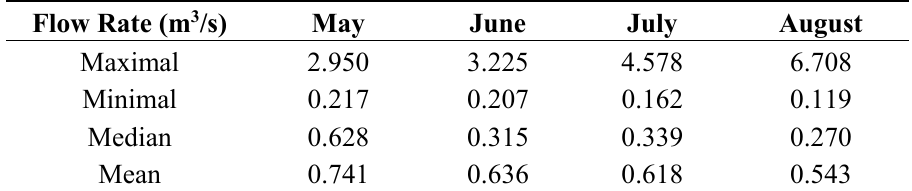
Table 2. Historical flow rates on Beauport River (from 2006 to